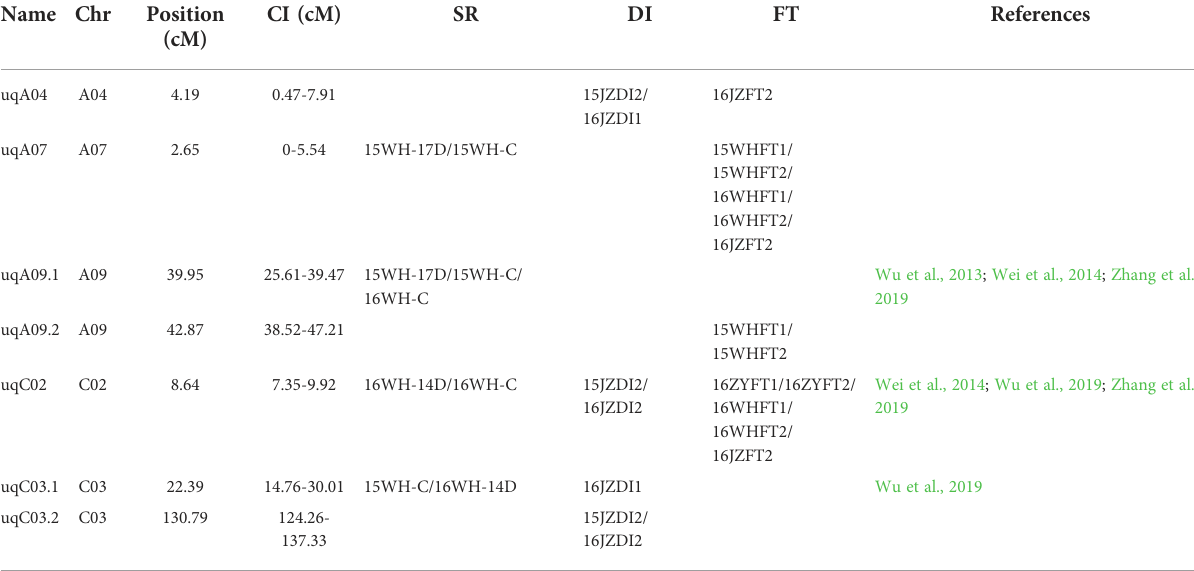
TABLE 1 Unique quantitative trait loci (QTL) information in this study. Name